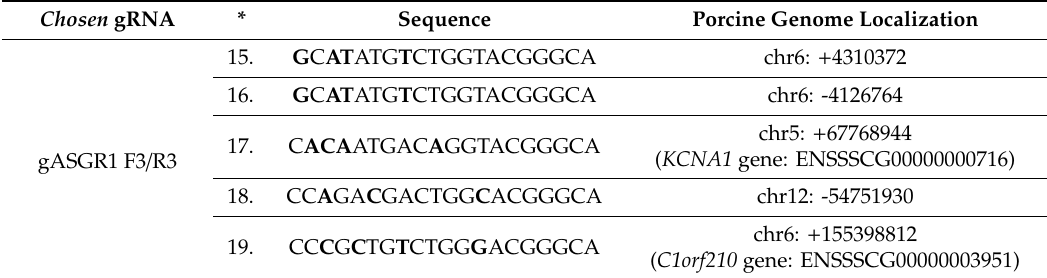
Table 4. Comparison of bioinformatic analysis with the results of laboratory analyses—analysis of the off-target sites presence.